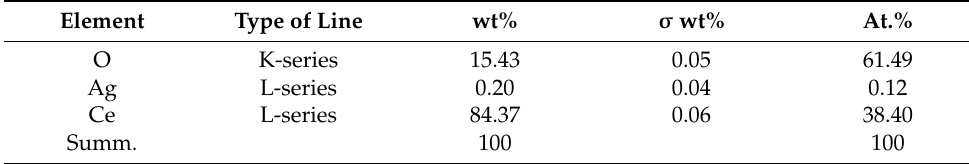
Table 2. Interpretation of the EDX spectrum of the CeO2-Ag4 sample.